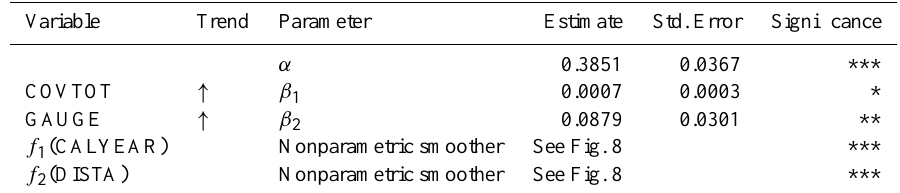
Table 12. Parameter estimates and significances for the model estimating the laser-scanned vegetation height (VEGHEIGHT) as shown in Eq. (16). Significance levels: ***: p < 0.001, **: p < 0.01, *: p < 0.05. The variance of the random effect a in Eq. (16) is 0.0074. Trend: qualitative illustration of linear predictor variables’ significant influences. ↑ , ↓ : VEGHEIGHT increases (decreases) with increasing values of the respective predictor variable.